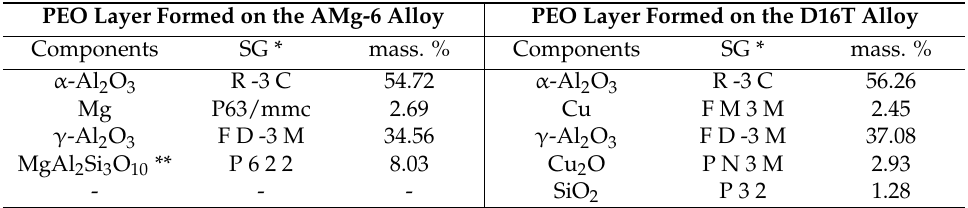
Table 2. Phase composition of the PEO layers synthesized on AMg-6 and D16T alloys. PEO Layer Formed on the AMg-6 Alloy